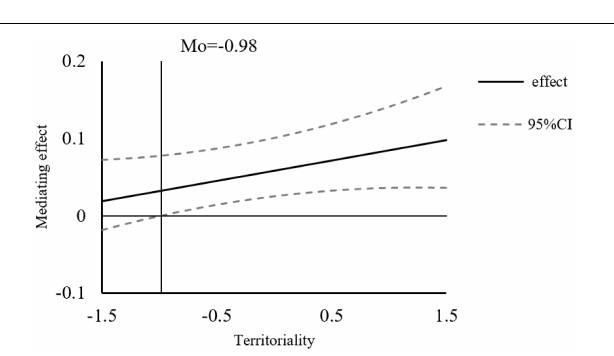
FIGURE 4 | Moderated mediating effect and confidence interval of victim